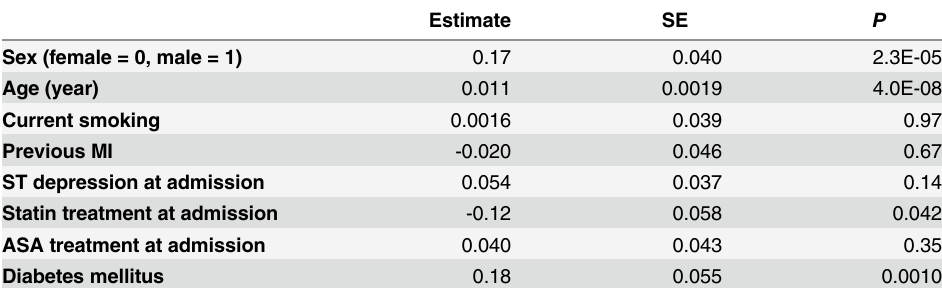
Table 2. Variables influencing IL-10 levels.